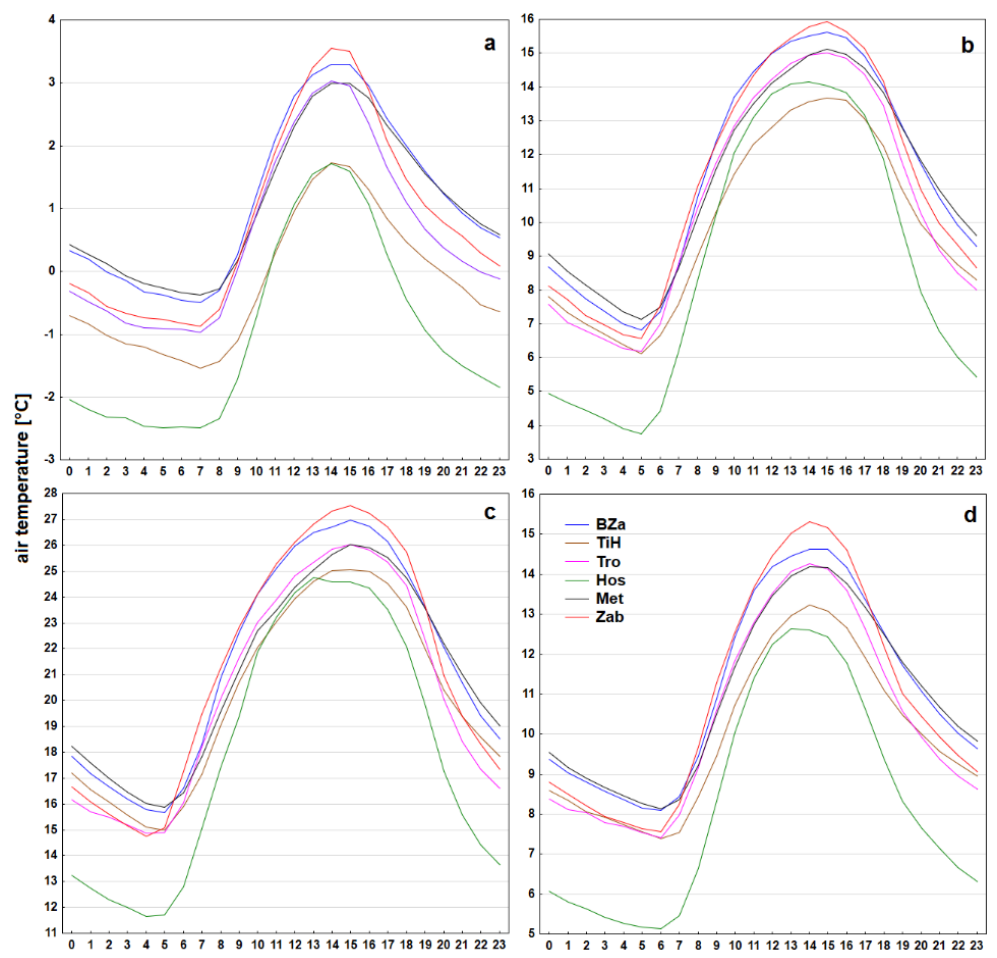
Figure 5. Seasonal ( a —winter, b —spring, c —summer, d —autumn) daily temperature courses on stations BZa, TiH, Tro, Hos, Met and Zab for the period 2015–2017; the time axis corresponds to CET.